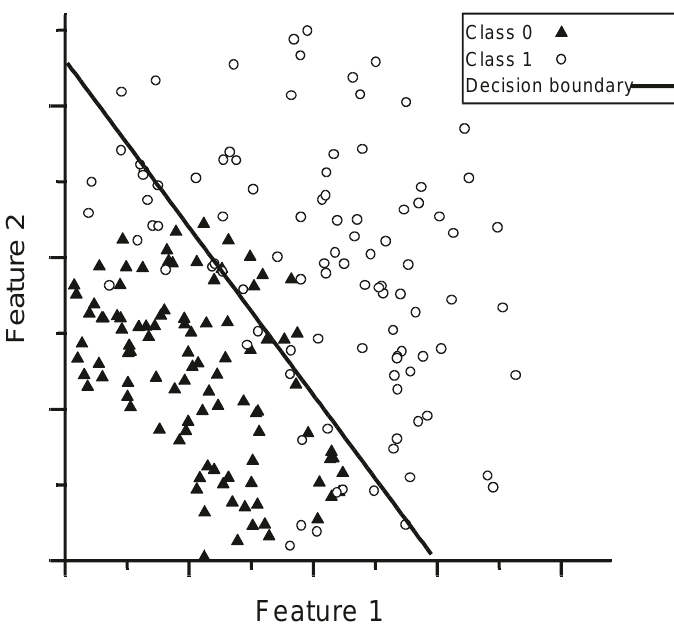
Fig. 5. The decision boundary is shown for the linear discriminant function.